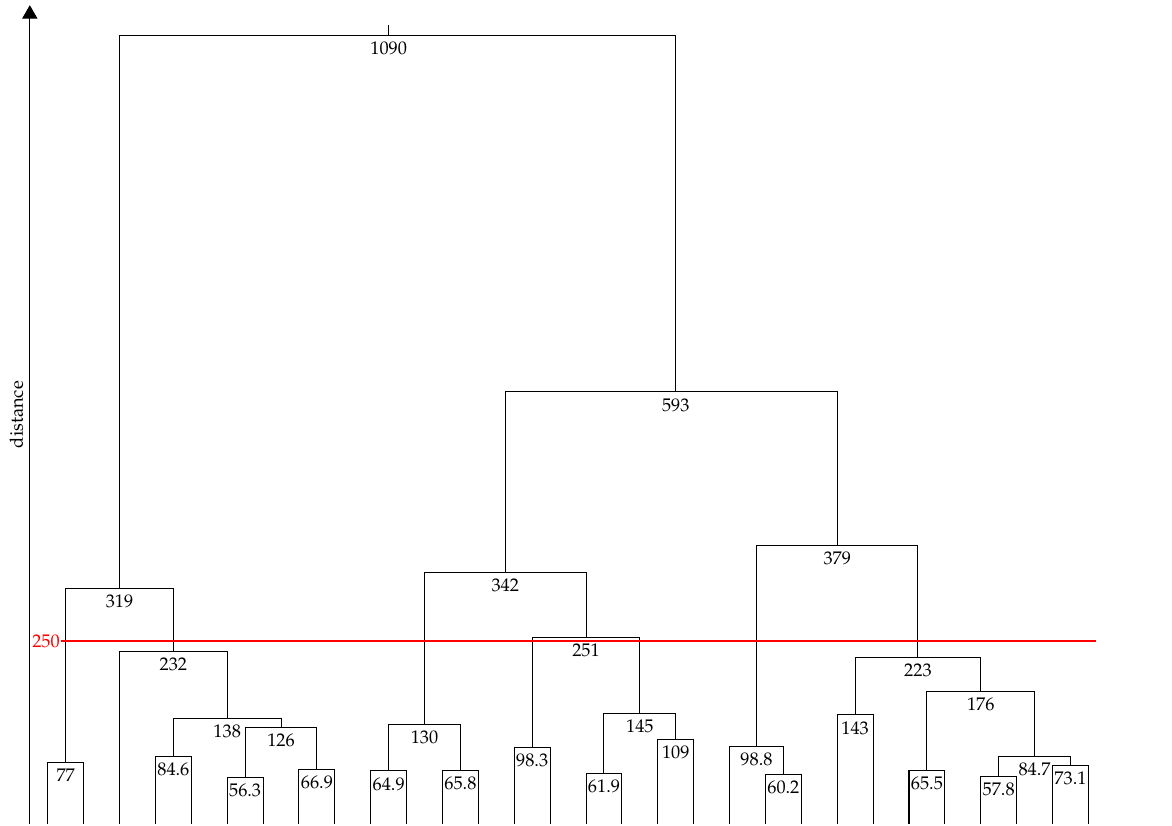
Figure 6. Dendrogram when running the hierarchical clustering method on the COOLL data set. The highlighted line depicts a minimum cluster distance value of 250, such that seven clusters are being returned. Values for distances below 50 were removed from the diagram for the sake of visual clarity. The horizontal highlighted line demarcates one possible threshold choice to yield seven